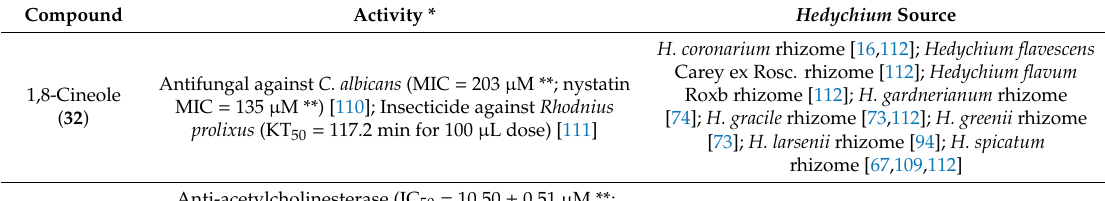
Table 3. The five most frequent and abundant chemical compounds identified in essential oils from Hedychium